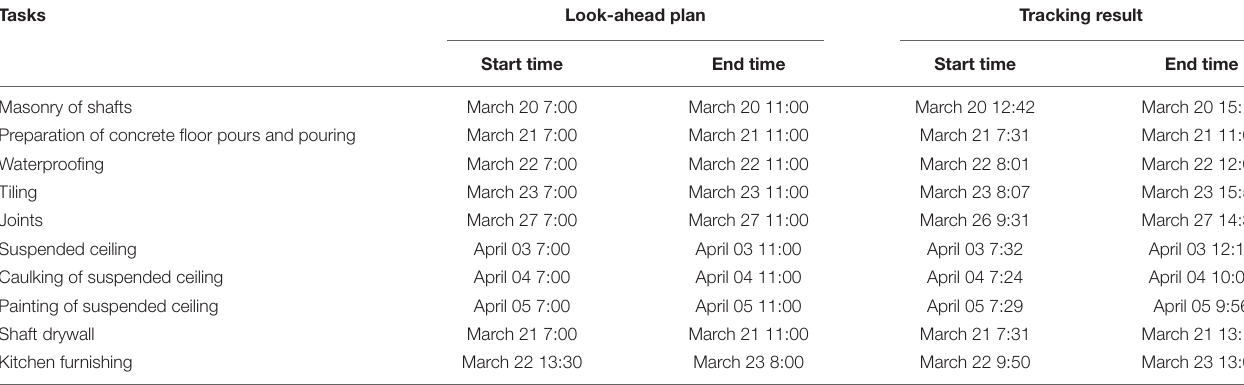
TABLE 3 | The scheduled start and finish time of tasks on floor 5 compared with the results based on the real-time tracking system. Tasks Look-ahead plan